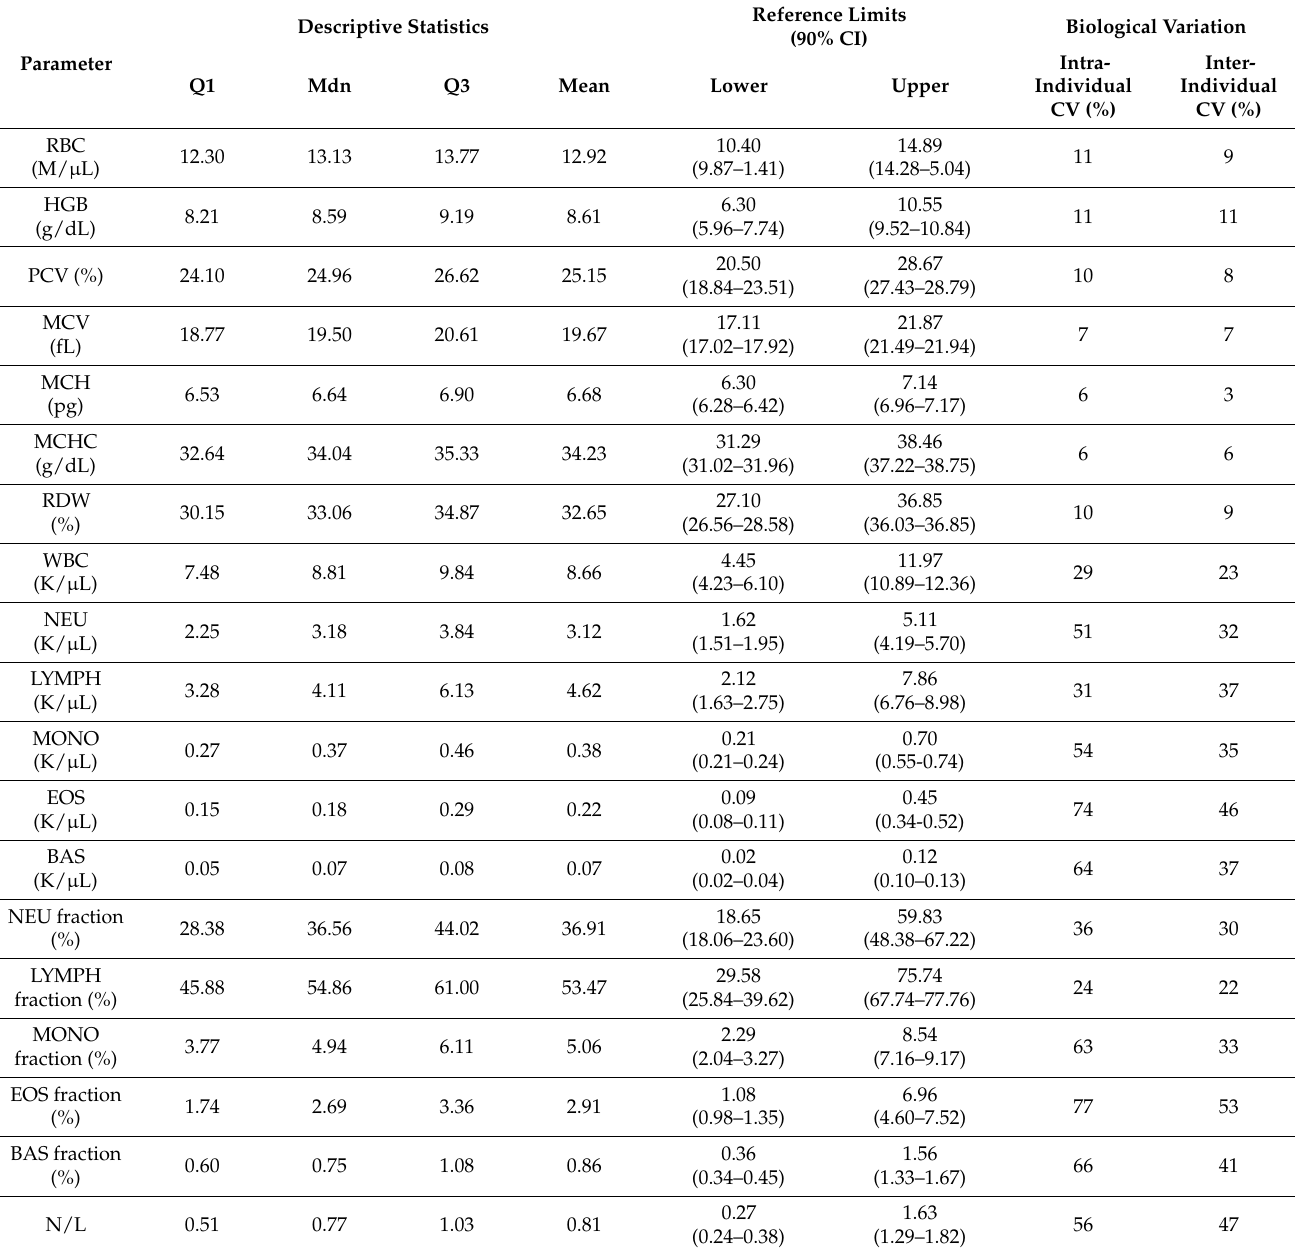
Table 1. Descriptive statistics, reference limits, and biological variation for hematological variables in Camosciata delle Alpi